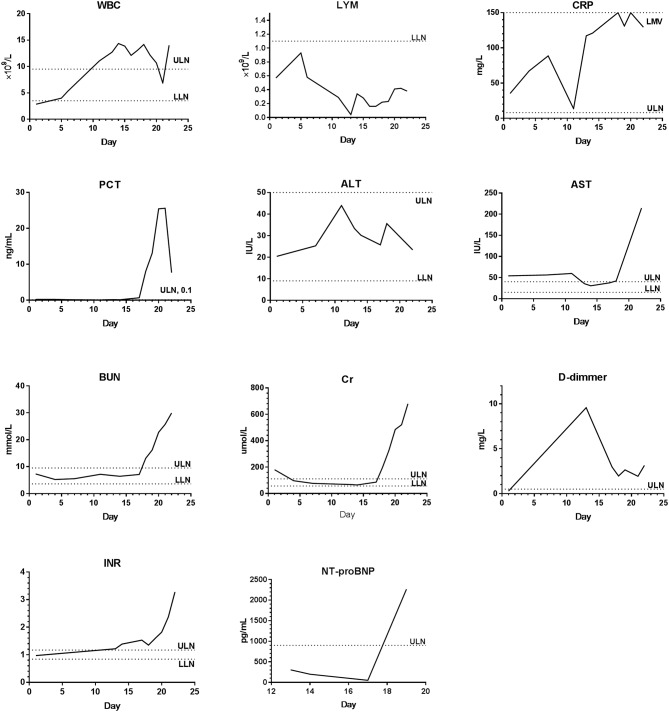
The dynamics of the main laboratory examinations of P7. WBC, White blood cell count; LYM, Lymphocyte count; CRP, C-reactive protein; PCT, Procalcitonin; ALT, Alanine aminotransferase; AST, Aspartate aminotransferase; BUN, Blood urea nitrogen; Cr, Creatinine; INR, International normalized ratio; NT-proBNP, N-terminal pro-B type natriuretic peptide; ULN, Upper limit of normal; LLN, Lower limit of normal.